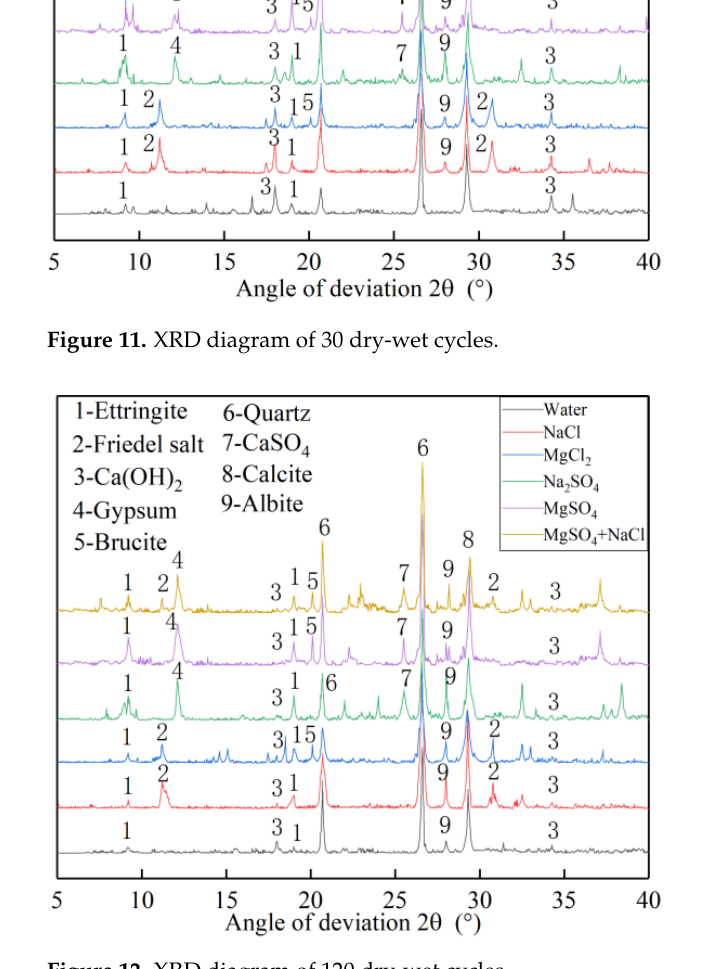
Figure 12. XRD diagram of 120 dry-wet cycles.